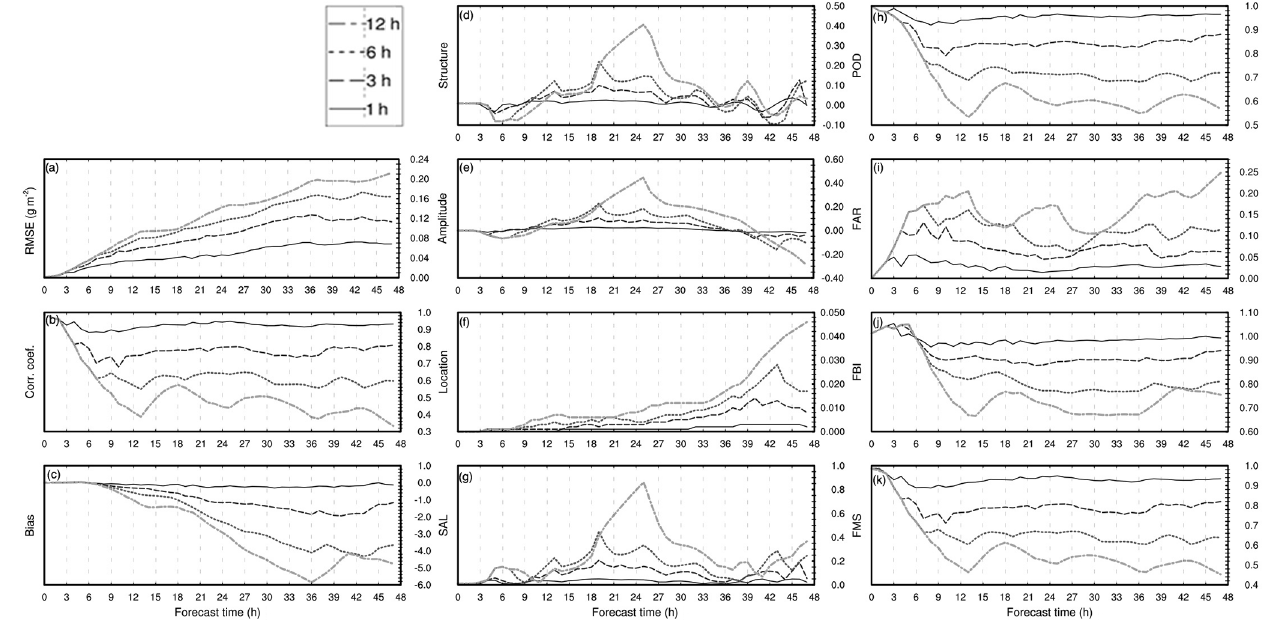
Figure 14. Online vs. offline evaluation scores for the 2011 Cordón Caulle application.